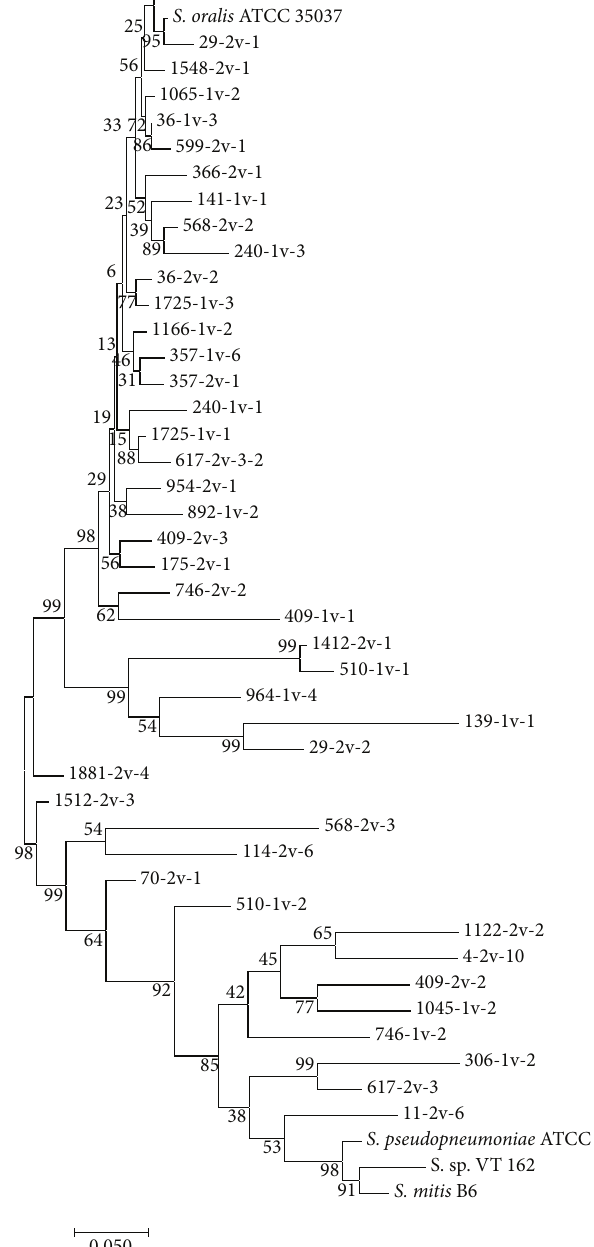
Figure 2: Molecular phylogenetic tree of MLSA concatenated sequences for the map, pfl, ppaC, and tuf genes. The evolutionary history was inferred by using the Maximum Likelihood Method based on the Tamura-Nei model [15]. The tree with the highest log likelihood is shown. The percentage of trees in which the associated taxa clustered together is shown next to the branches. Initial tree(s) for the heuristic search were obtained automatically by applying Neighbor-Join and BioNJ algorithms to a matrix of pairwise distances estimated using the Maximum Composite Likelihood (MCL) approach and then selecting the topology with superior log likelihood value. The tree is drawn to scale, with branch lengths measured in the number of substitutions per site. Evolutionary analyses were conducted in MEGA7 [16]. The